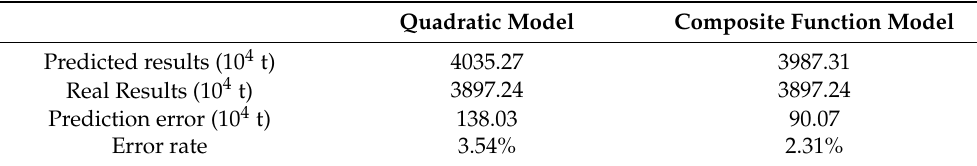
Table 9. Results of secondary and compound model